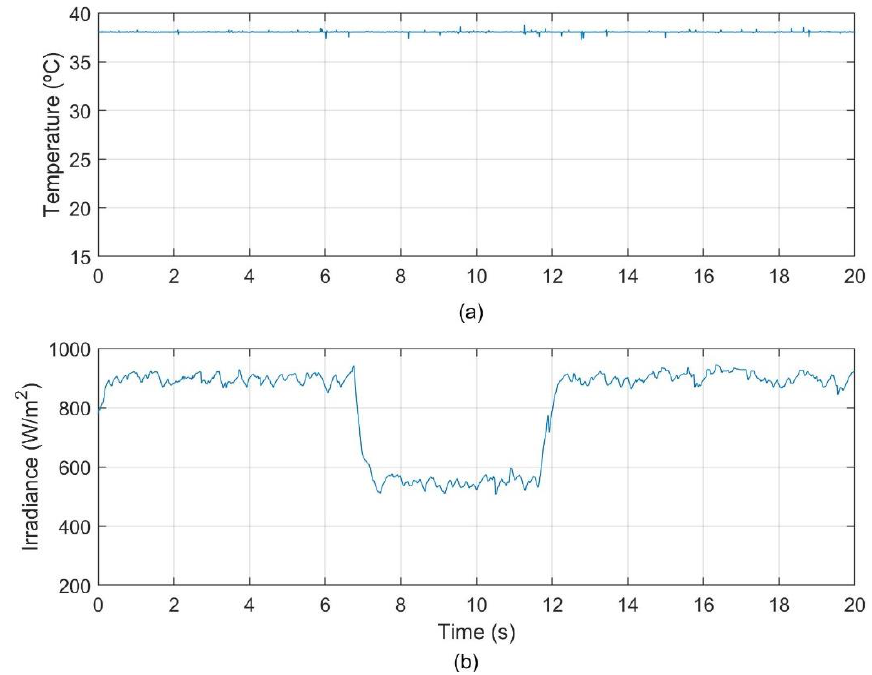
Figure 10. Evolution of the environmental conditions: ( a ) temperature; ( b ) irradiance.